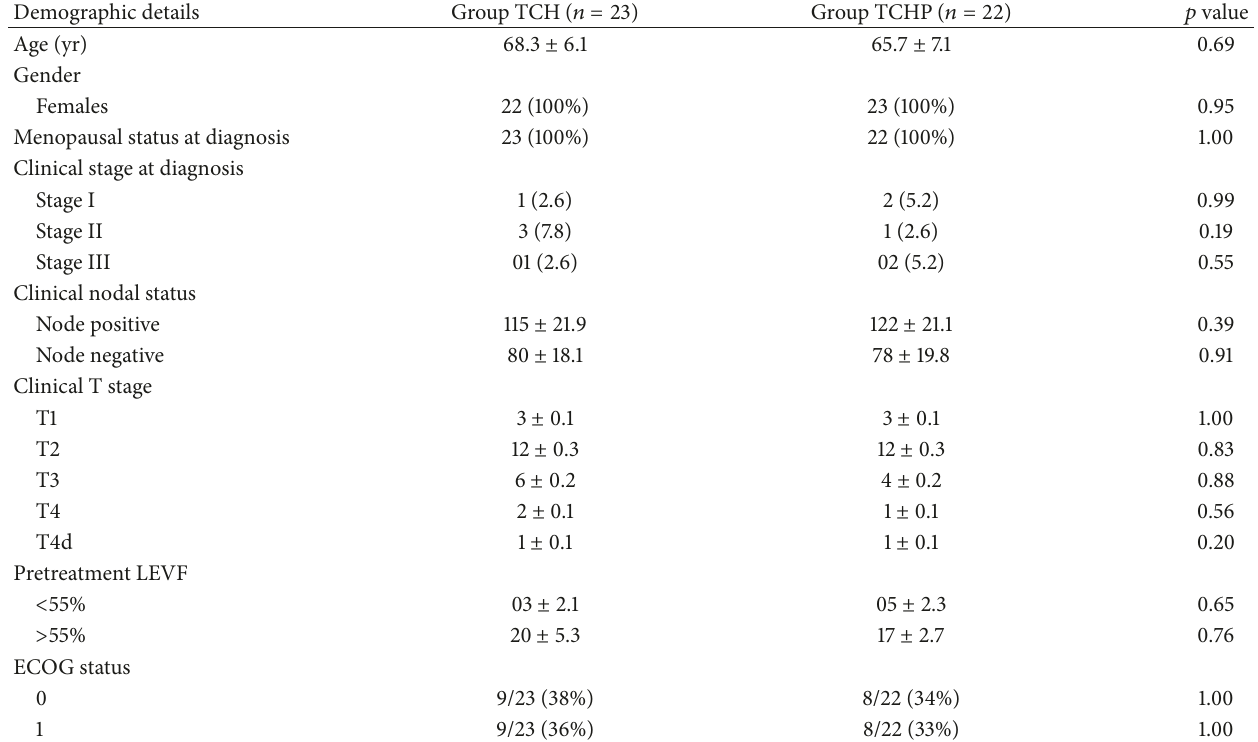
Table 1: Baseline clinical characteristics of the study patients (𝑛 = 45)